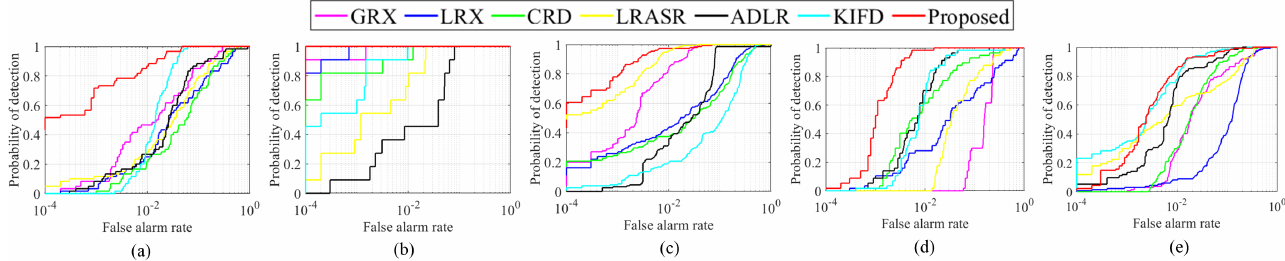
Figure 7. ROC curves of the compared AD methods on five images. ( a ) airport-4; ( b ) beach-3;